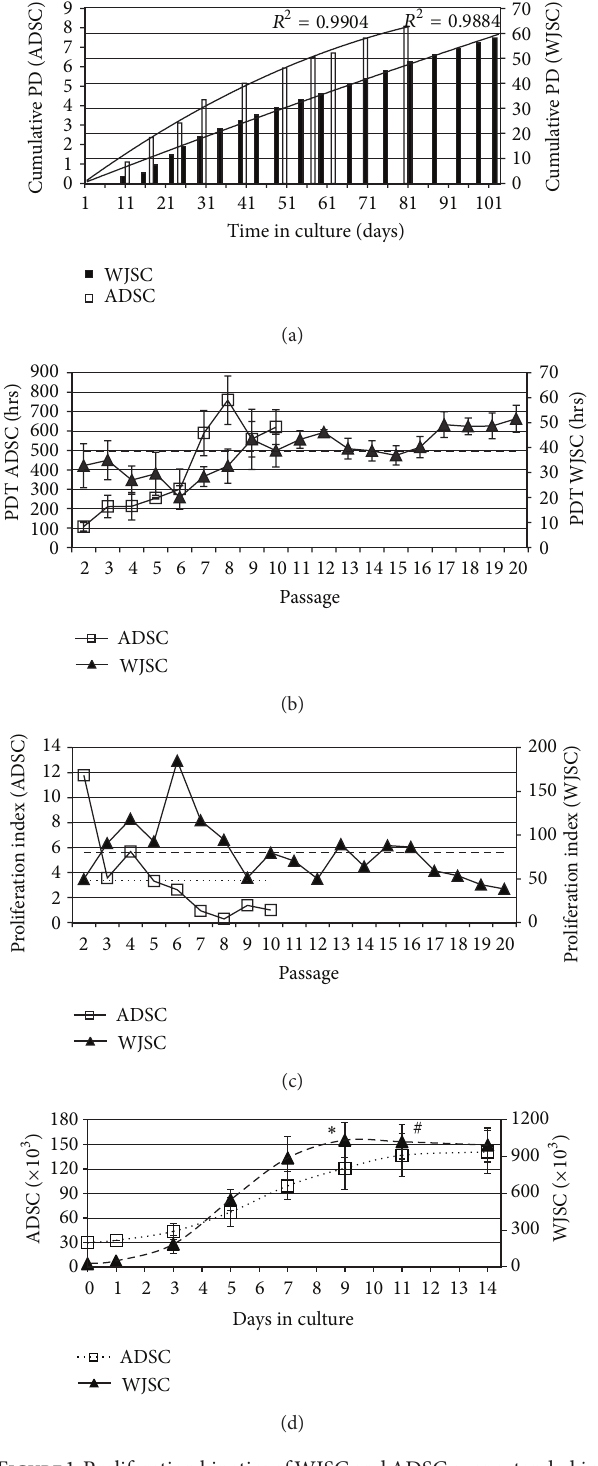
Figure1:ProliferationkineticsofWJSCandADSCoverextended in vitro propagation. (a) Number of cumulative population doublings (PD) as a function of time in culture; (b) cell population doubling times—PDT—(hrs) at respective passages; (c) proliferation index (PI; ratio of PD over respective PDT); (d) growth curve of WJSC and ADSC within a single passage (3 to 4). The ∗ and # symbols highlight the points when confluence was reached for WJSC and ADSC, respectively. Dashed and long dashed horizontal lines denote mean values for ADSC and WJSC, respectively.